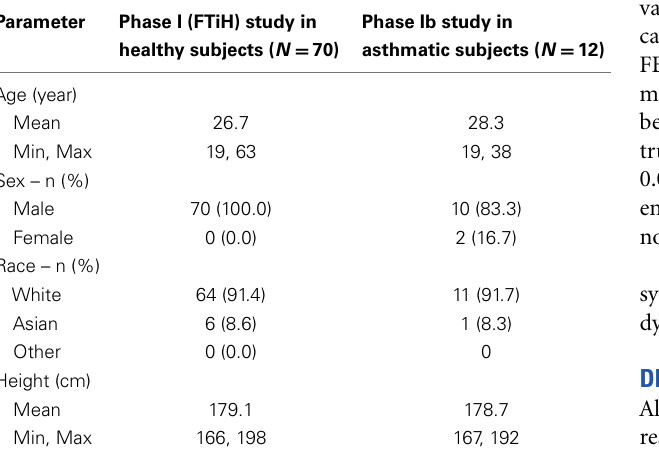
Table 1 | Summary of demographics in phase I and Ib trials – total population.